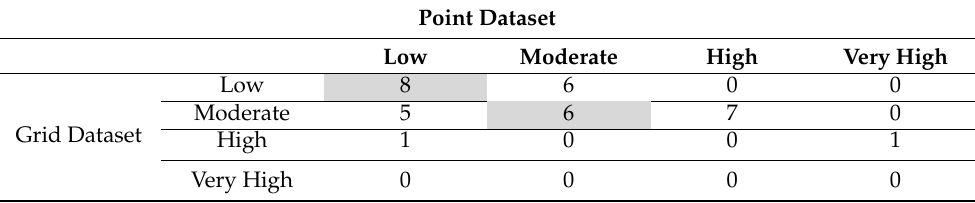
Table 2. Confusion matrix of MFI classes assigned to 34 stations based on the median MFI value (1980–2018) by point and grid datasets. Shaded cells indicate cases for which grid and point data assign same MFI classification.